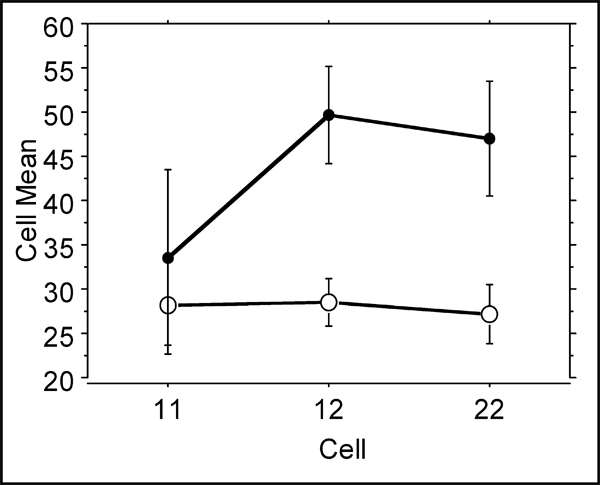
Percent attachment loss ≥ 4 mm among smokers (filled circles) and non-smokers (open circles) separated according to their Fcγ-RIIIb genotypes NA1/NA1, NA1/NA2 or NA/2NA2. Kruskal-Wallis test results in p = 0.024 and p = 0.797 for smokers and non-smokers, respectively.